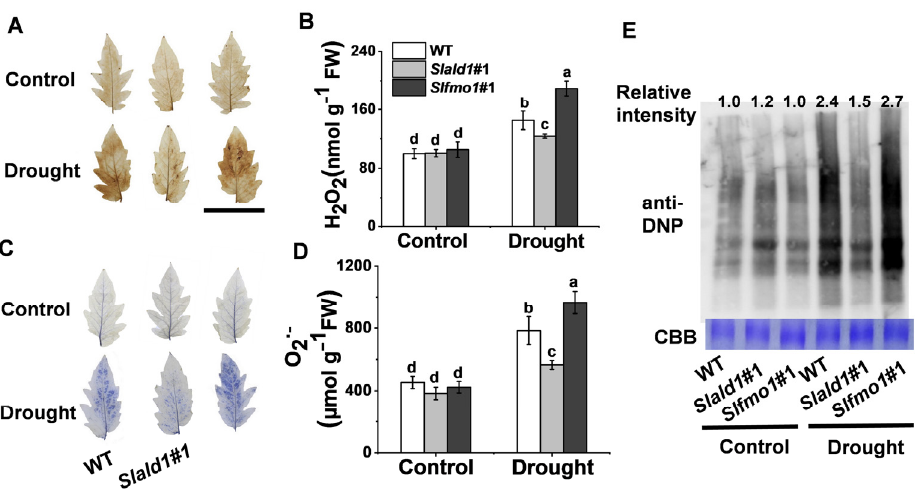
Figure 5. Drought ‐ induced changes in ROS concentrations and protein oxidation in Slald1 and Slfmo1 mutants. ( A ) Representative images of in situ H 2 O 2 accumulation detected by DAB staining. Bar = 5 cm ( B ) Quantification of H 2 O 2 . ( C ) Representative images of O 2 · − accumulation as determined by NBT staining. ( D ) Quantification of O 2 · − . ( E ) Oxidized protein levels as detected by immunoblot analysis with anti-DNP antibody. Leaf samples were collected from Slald1 , Slfmo1 mutants and WT plants after 48 h of control and drought treatment. The data are presented as mean values ± SD, n = 4. Different letters (a,b,c,d) above each bar indicate significant differences at p < 0.05 (Tukey’s test) among treatments.